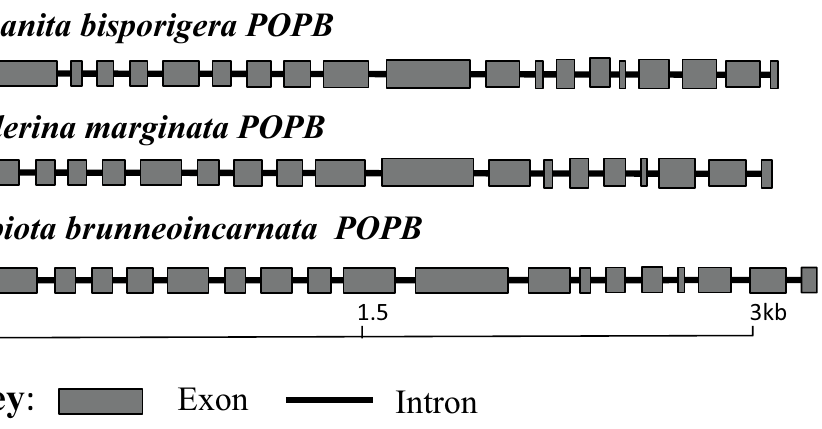
Fig. 7. POPB intron and exon structure for Amanita, Galerina, and